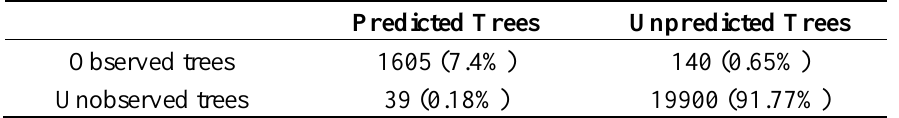
Table 7. Number and percentage of encoder events recorded in each situation during the LIDAR calibration tests.